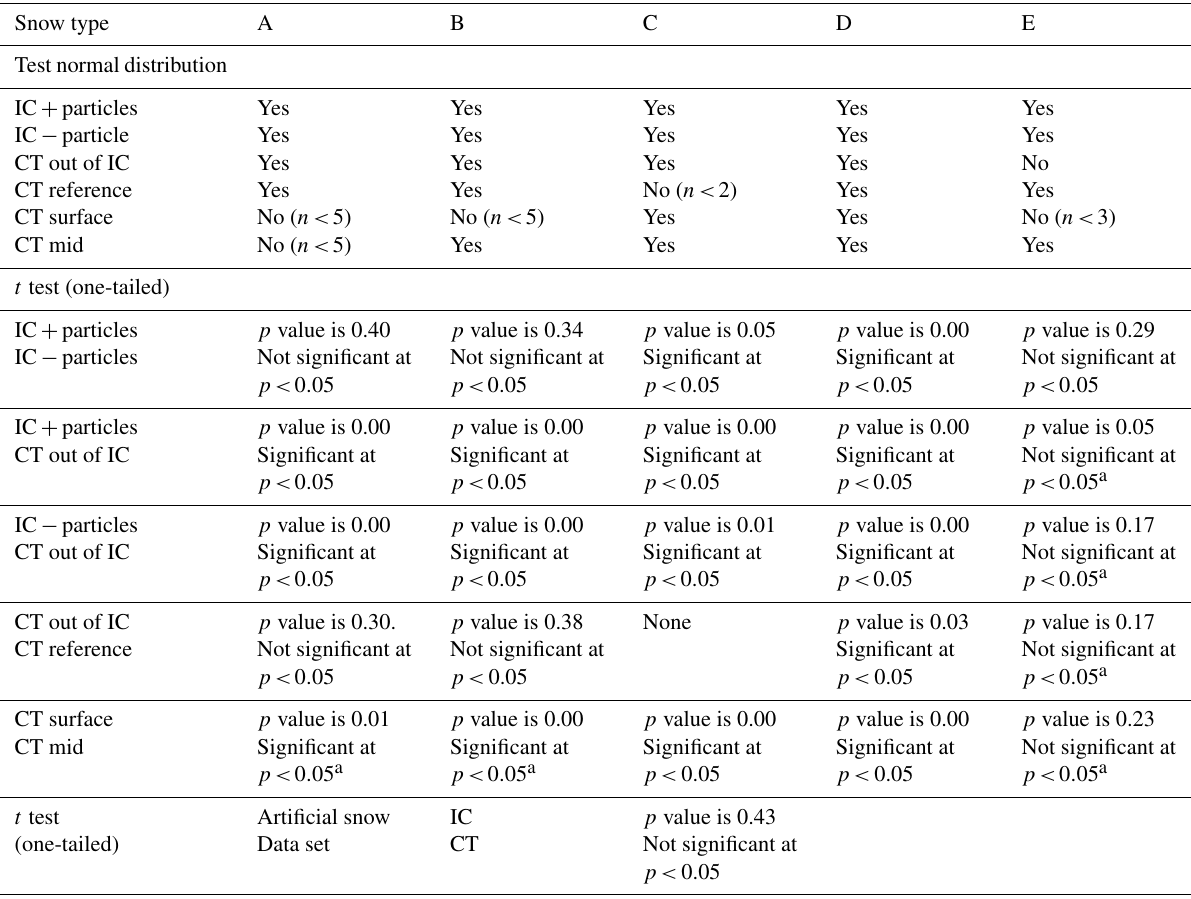
Table A1. Summary of the statistical analyses. The first step was to test for a normal distribution. Testing for significant differences between the sampling steps was then carried out. “IC + particles” represents the default sampling procedure suggested by Gallet et al.